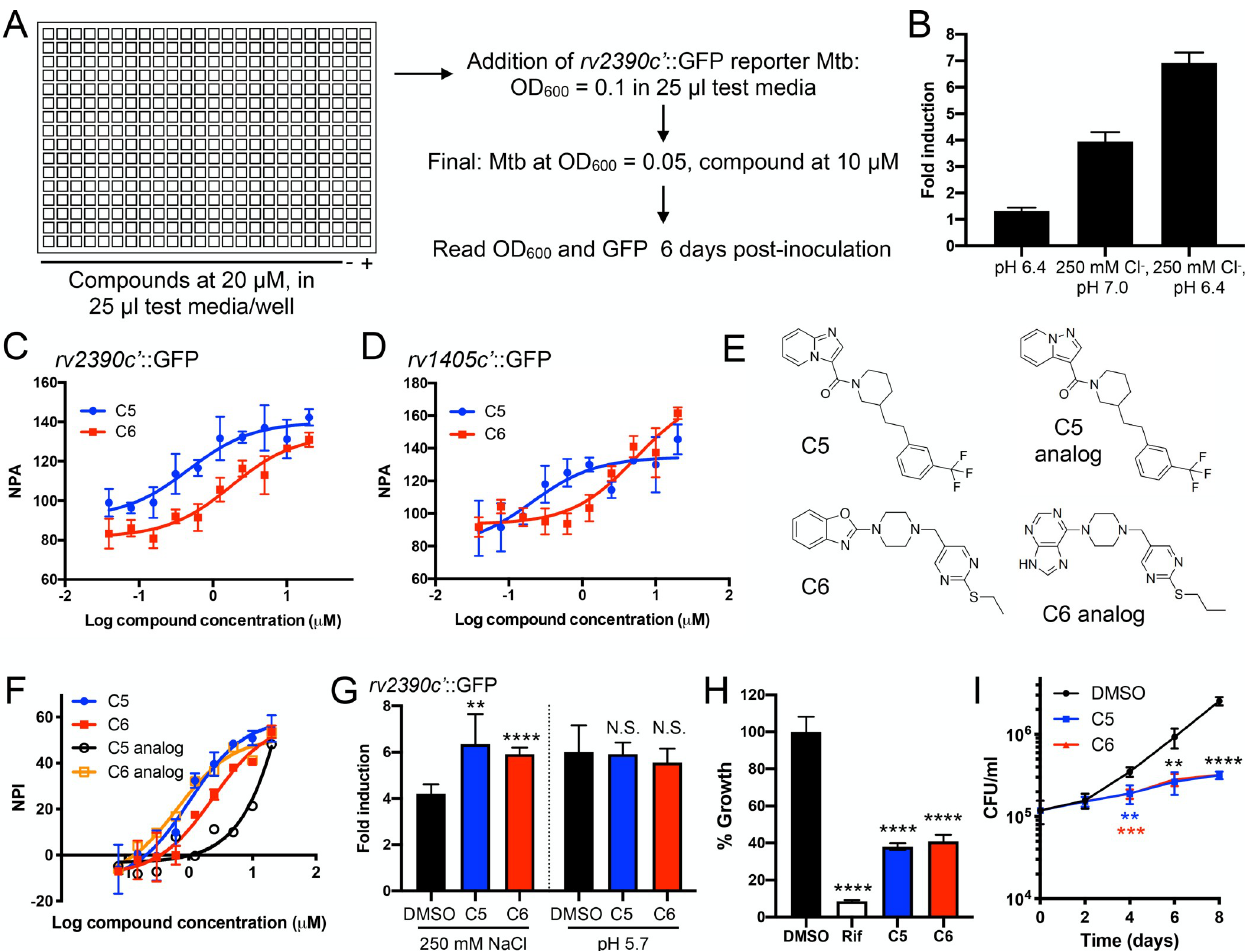
Fig 1. Reporter-based chemical screen identifies compounds that modulate Mtb response to environmental chloride levels and inhibit Mtb colonization of host macrophages. (A) rv2390c 0 ::GFP screen set-up. Schematic of the compound screen conducted in 384-well plates. DMSO-treated control wells with Mtb in 7H9 (pH 6.4) media (negative, − ) or 7H9 (pH 6.4), 250 mM NaCl media (positive, +) were included in each plate. (B) Dual high [Cl − ], slightly acidic pH conditions provide increased reporter dynamic range. Mtb carrying the rv2390c 0 ::GFP reporter was grown for 6 days in pH 7 control media or in the indicated conditions in a 384-well plate format. Fold induction represents rv2390c 0 ::GFP signal/OD 600 in each test condition as compared to the pH 7 control, measured by a microplate reader. Data are shown as means ± SD from 16 wells. (C) Dose response curve validation of 2 hit compounds. Mtb carrying the rv2390c 0 ::GFP reporter was grown for 6 days in pH 6.4, 250 mM NaCl media treated with the indicated compound, in a 384-well plate format with controls as shown in the schematic in (A). NPA was calculated by setting GFP signal/OD 600 of the reporter observed in the DMSO-treated positive control condition at 100% and comparing the compound-treated GFP signal/OD 600 values to that baseline. Data are shown as means ± SD from 3 wells. The AC 50 of compounds C5 and C6 was 0.5 μ M and 1.8 μ M, respectively. (D) Secondary screen results of 2 hit compounds. Mtb carrying the rv1405c 0 ::GFP reporter was grown and assayed as in (C). Data are shown as means ± SD from 2–3 wells. (E) Structures of compounds C5 and C6 and their respective analogs in the screen. (F) Dose response curve testing of effect of hit compounds on Mtb growth in J774 macrophage-like cells. Mtb constitutively expressing mKO was used to infect J774 cells in a 384-well format, and cells treated with compounds, 5 μ M rifampicin, or DMSO as a carrier control. mKO fluorescence was measured 6 days post-infection with a microplate reader. NPI was calculated by setting mKO signal observed in the rifampicin-treated condition as 100% inhibition (versus signal observed in the DMSO-treated controls) and comparing the mKO values in the compound-treated wells to that baseline. Data are shown as means ± SD from 2 wells. (G) Compounds C5 and C6 increase rv2390c 0 ::GFP reporter response upon bacterial exposure to high [Cl − ]. Mtb carrying the rv2390c 0 ::GFP reporter was grown for 9 days in 7H9 (pH 7.0) ± 250 mM NaCl or 7H9 (pH 5.7), treated with DMSO as a carrier control, 10 μ M C5 or 10 μ M C6. Reporter signal in fixed samples was measure by flow cytometry, with fold signal induction compared to the corresponding treatment in the 7H9 (pH 7) control condition. Data are shown as means ± SD from 5 experiments. p -values were obtained with an unpaired t test, comparing each compound treatment to DMSO treatment for each condition. N.S., not significant, �� p < 0.01, ���� p < 0.0001. (H) C5 and C6 inhibit growth in J774 cells. J774 macrophage-like cells were infected with Mtb constitutively expressing mKO and treated with DMSO, 5 μ M rifampicin, 10 μ M C5, or 10 μ M C6. Bacterial growth was tracked by fluorescence, with readings taken 6 days post-infection. DMSO is the carrier control, and growth in that condition is set at 100%. Data are shown as means ± SD from 3–4 wells. p -values were obtained with a one-way ANOVA with a Dunnett multiple corrections test, and treatment sets compared to the DMSO control. ���� p < 0.0001. (I) C5 and C6 inhibit growth in primary BMDMs. BMDMs were infected with WT Mtb and bacterial load determined at indicated times. DMSO as a carrier control, 10 μ M C5 or 10 μ M C6 was added 2 hours post-infection. Data are shown as means ± SD from 4 wells, pooled from 2 independent experiments. p -values were obtained with an unpaired t test, comparing each treatment to the DMSO control for a given